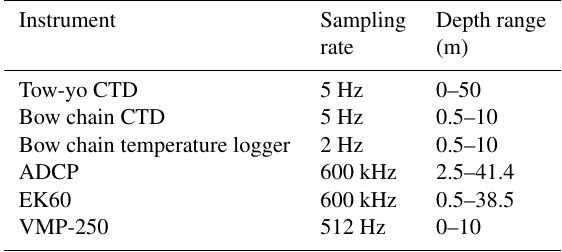
Table 1. Summary of Vessel-Mounted Instrumentation ∗ .